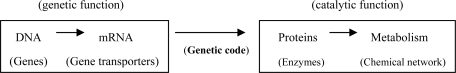
The role of genetic code playing in the fundamental life system of modern organisms.